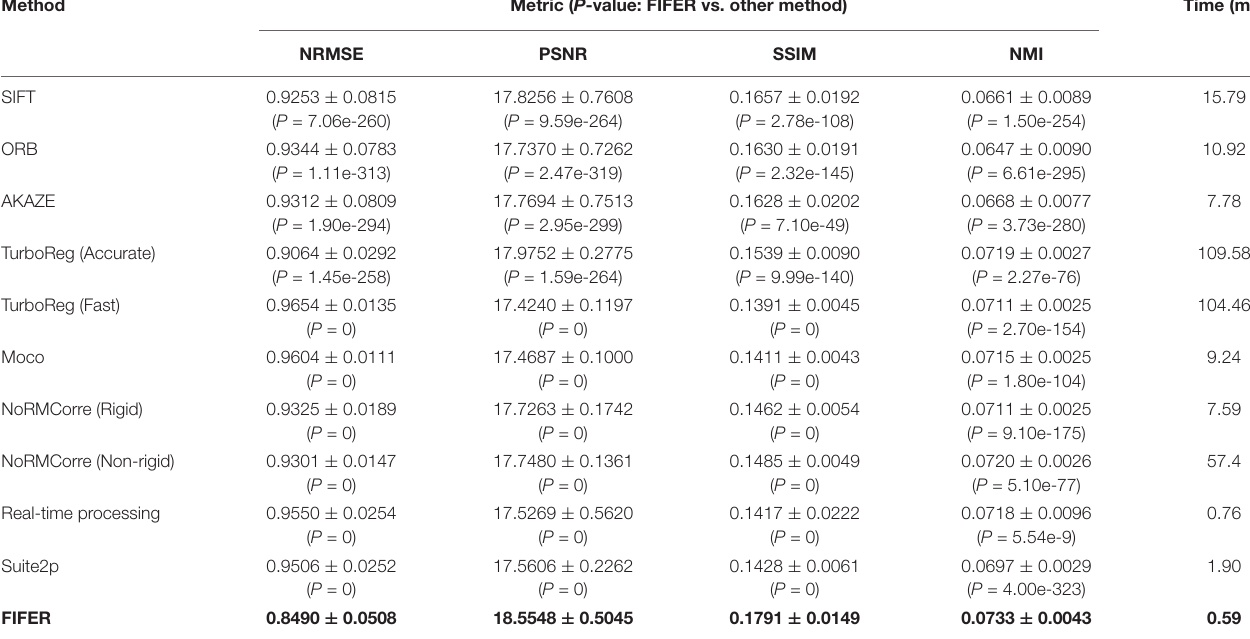
TABLE 2 | Comparison of FIFER with other methods (mean ± SD) for dendritic spine imaging dataset ( n = 1500 frames, 250 × 250 pixels for each frame). Method Metric ( P -value: FIFER vs. other